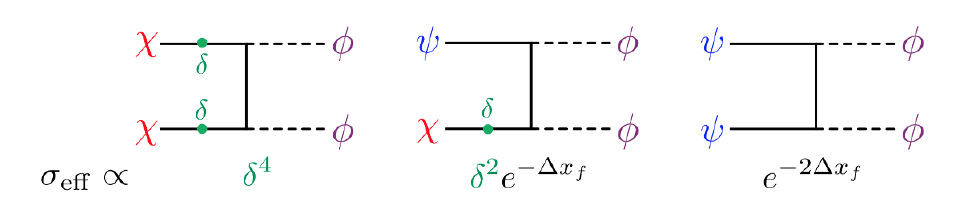
Figure 5 . Annihilation channels for the model presented in section 2.2. The DM particle can approximately be identi(cid:12)ed with (cid:31) . In the regime: (cid:14) 2 (cid:28) e (cid:0) (cid:1) x f , annihilations dominate and we realize sterile coannihilation. In the opposite limit, (cid:14) 2 (cid:29) e (cid:0) (cid:1) x f , (cid:31)(cid:31) annihilations dominate and the model becomes